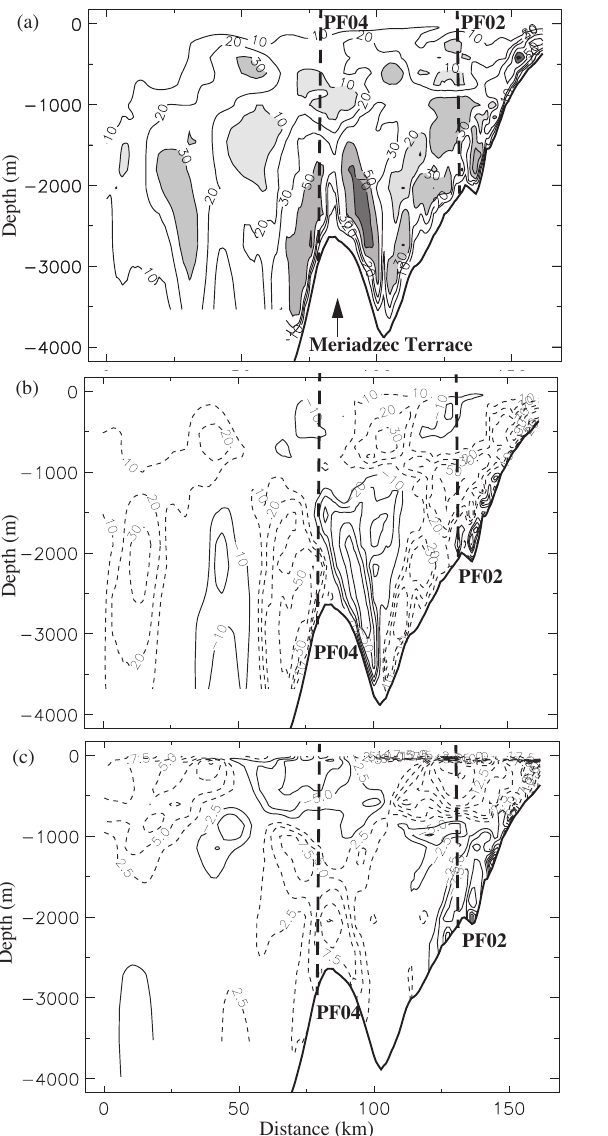
F IG . 8. – (a) Distribution of the internal tide amplitude along section F IG . 9. – (a) Distribution of the internal tide amplitude along section S1 from 9.5°W 46.9°N (PF05) to 8.5°W 48.10°N (close to DP941), S2 from 8.23°W 46.25°N (PF10) to 7.0°W 47.6°N, calculated as for calculated as for section S (Fig. 7b). (b) Distribution of the interface section S (Fig. 7b). (b) Distribution of the interface elevations along elevations along S1 on 09/09 at 19 h (the same tidal hour as for Fig. S2 on 09/09 at 21 h. (c) Distribution of the total across-slope veloc- 7). (c) Distribution of the total across-slope velocity along S1 on ity along S2 on 09/09 at 21 h. The angle between the normal to the 09/09 at 19 h. The angle between the normal to the bottom slope and bottom slope and the north is 25 ° . Dotted lines are negative values, the north is 30 ° . Dotted lines are negative values, dashed lines are dashed lines are positive values. The bold shaded line is the PF06 positive values. The two bold shaded lines are the PF04 and PF02 locations.